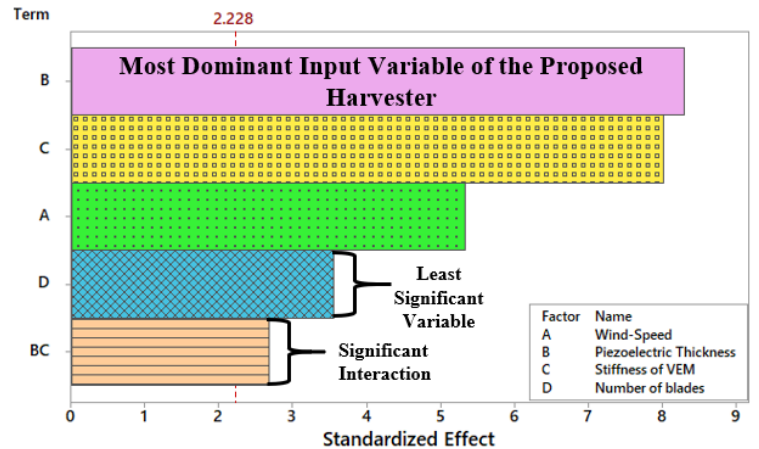
Figure 13. Selection of dominant input factors via Pareto chart. values of VEM stiffness (40 Nm −1 ), rotor-blades (3), and PZT thickness (3 mm).